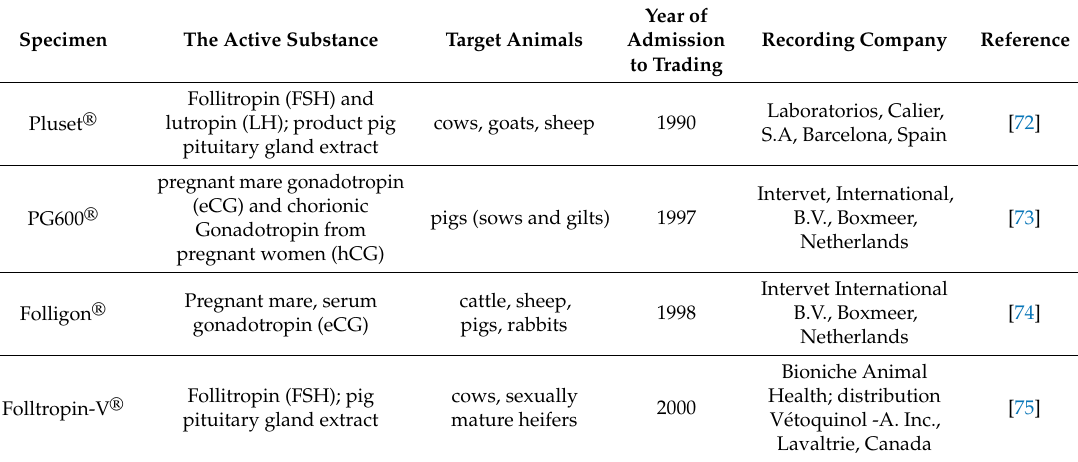
Table 3. Examples of hormone drugs for animal